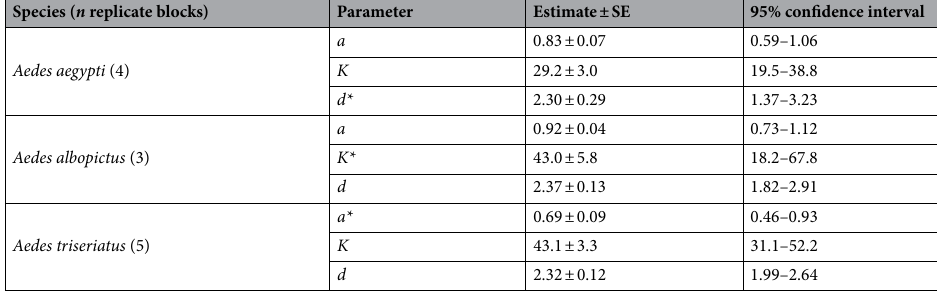
Table 3. Best fit parameters for the relationships of surviving adults S vs. initial density N (Eq. 2) for Aedes aegypti, Aedes albopictus, and Aedes triseriatus that are shown in Fig. 2. See Table 2 for model selection via AICc. For each species the parameter that varied among replicate blocks is indicated with an *.